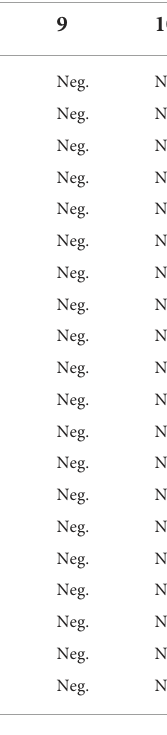
TABLE 6 LSD virus isolation in cell culture from pathological materials of experimental animals. Animal Type of pathological material number Lymph Skin Nasal Lungs Skeletal nodes mucosa muscle 1 Neg. Neg. Neg. Neg. Neg. 2 Pos. Pos. Pos. Pos. Neg. 3 Pos. Pos. Pos. Pos. Neg. 4 Pos. Neg. Pos. Pos. Pos. Pos. Pos. Pos. Pos. Neg. Neg. Pos. Pos. Neg. Neg. Neg. Neg. Neg. Neg. Neg. Neg. Neg. Neg. Neg.